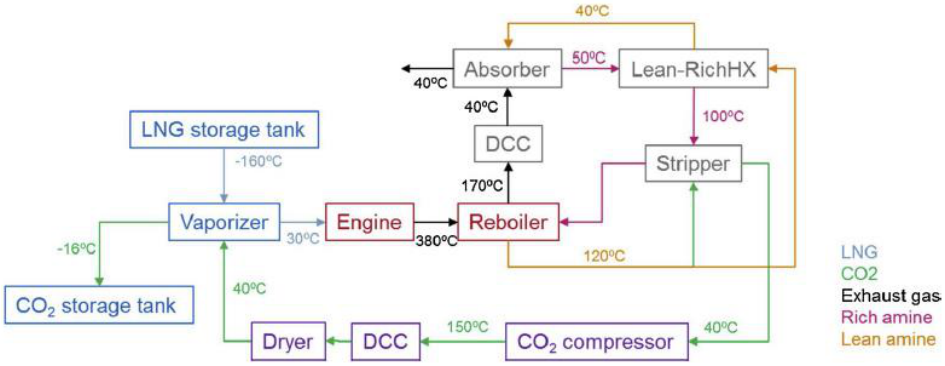
Figure 16. Process schematics for an on-board post-combustion CCS integrated with a LNG-powered engine. Reprinted with permission from ref. [86]. Copyright © 2019 Elsevier Ltd. All rights reserved.